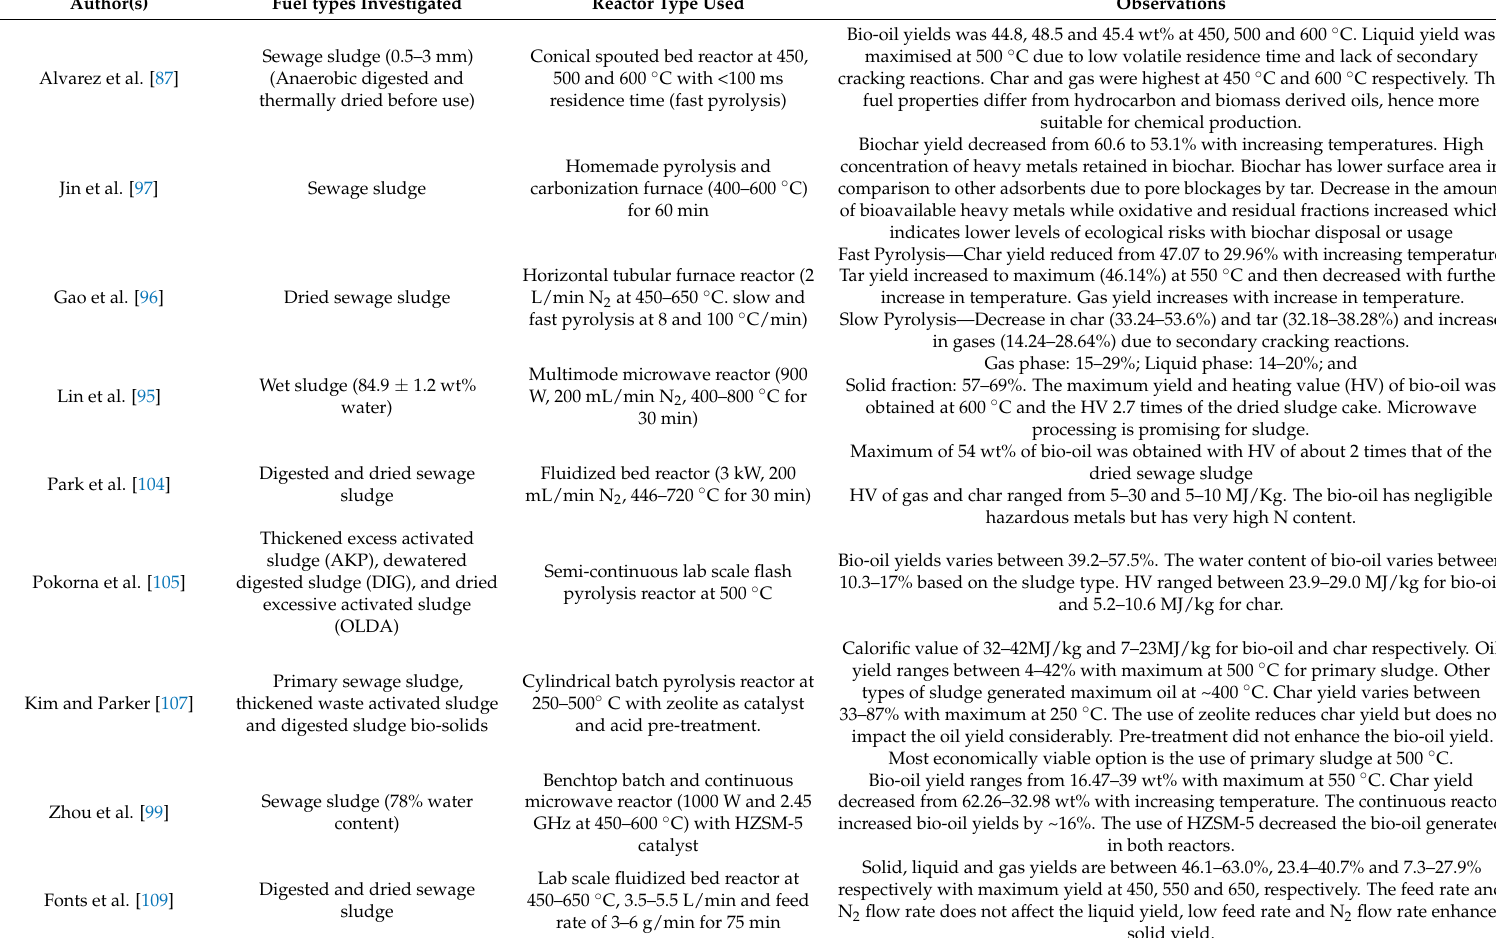
Table 4. Summary of key research on pyrolysis of sewage